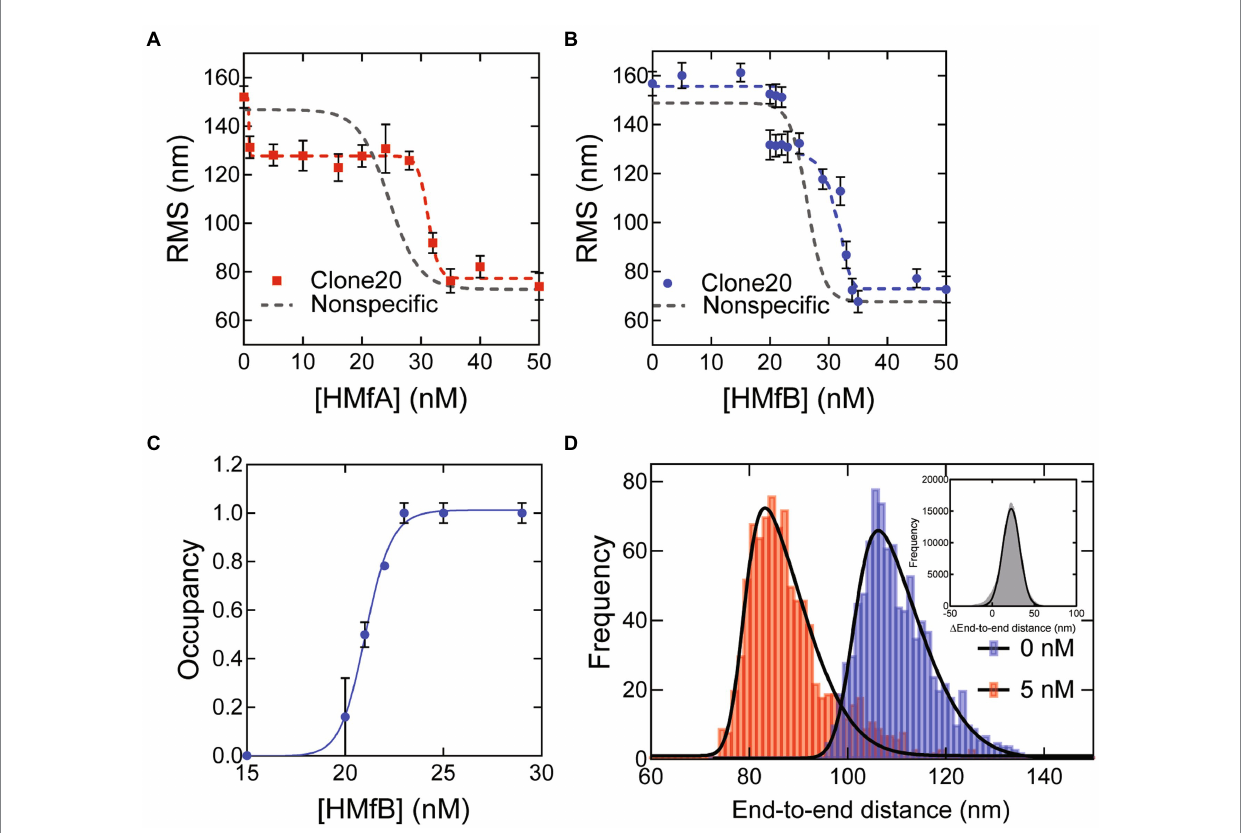
FIGURE 1 HMfA and HMfB bind as tetramers to the Clone20 site preceding hypernucleosome formation. (A) Root mean square displacement (RMS) values of Nonspecific and Clone20 DNA tethers incubated with HMfA and (B) with HMfB measured by TPM in 50 mM Tris–HCl pH 7, 75 mM KCl. Histograms were fitted with a Gaussian function and the mean values are represented by red and blue dots, respectively. Data for Nonspecific DNA was reproduced from Henneman et al. (2021) and depicted as a line to guide the eye. Error bars represent the propagated standard deviation of at least two replicates (C) Binding curve for specific binding of HMfB to the Clone20 substrate. The data points were fitted using the Hill binding model. Error bars represent the standard deviation of the replicates and propagated error for data points at saturation. (D) Calculated end-to-end distances for unbound Clone20 DNA and with 5 nM HMfA. Histograms were fitted with a skewed normal distribution. Insert: pairwise distribution plot of the difference between the two end-to-end distance populations. Histogram was fitted with a Gaussian